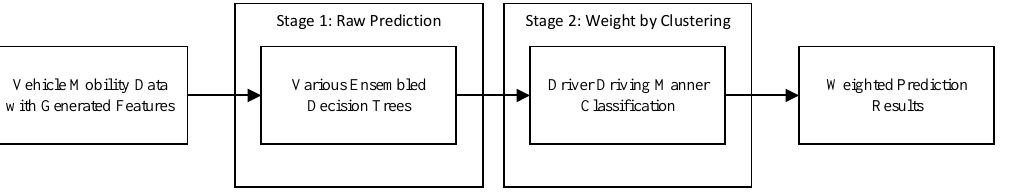
Figure 3. Two-stage method schematic diagram.